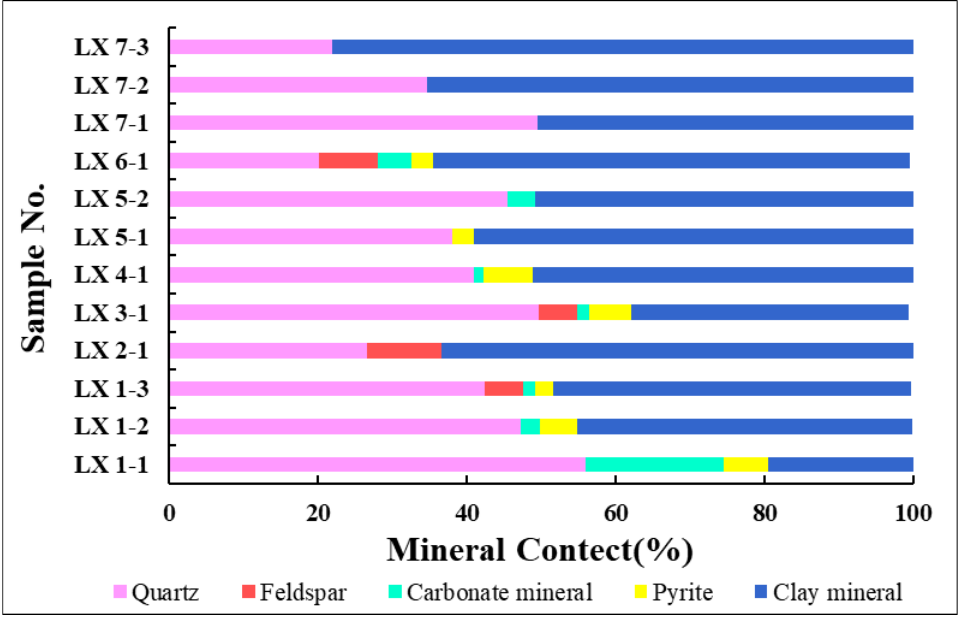
Figure 2. Mineral compositions of the Taiyuan Formation shale. Table 3. Clay mineral compositions of the Taiyuan Formation shale, Lin-Xing area. Table 1. Organic matter types in shale from the Taiyuan Formation in the study